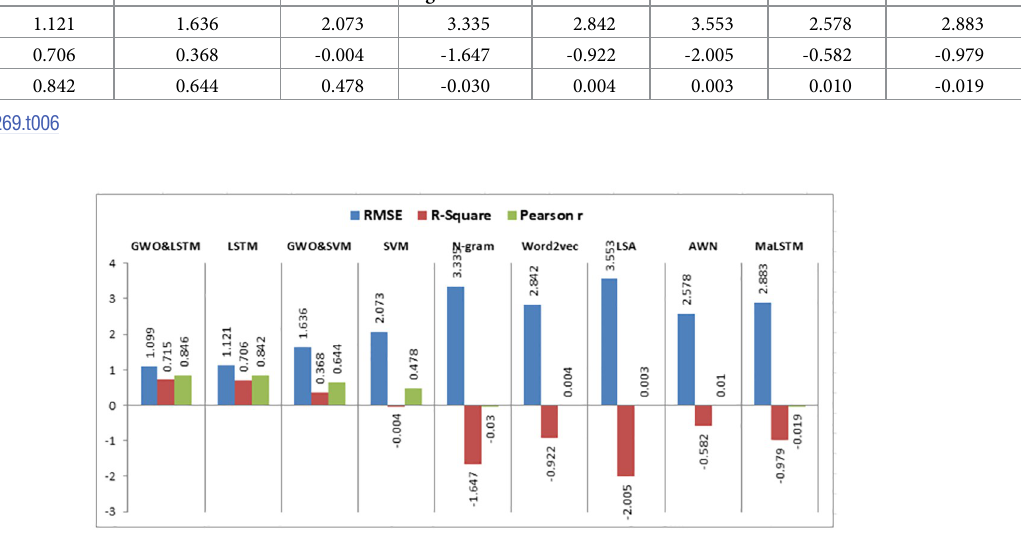
Fig 24. LSTM-GWO performance evaluation with experiment